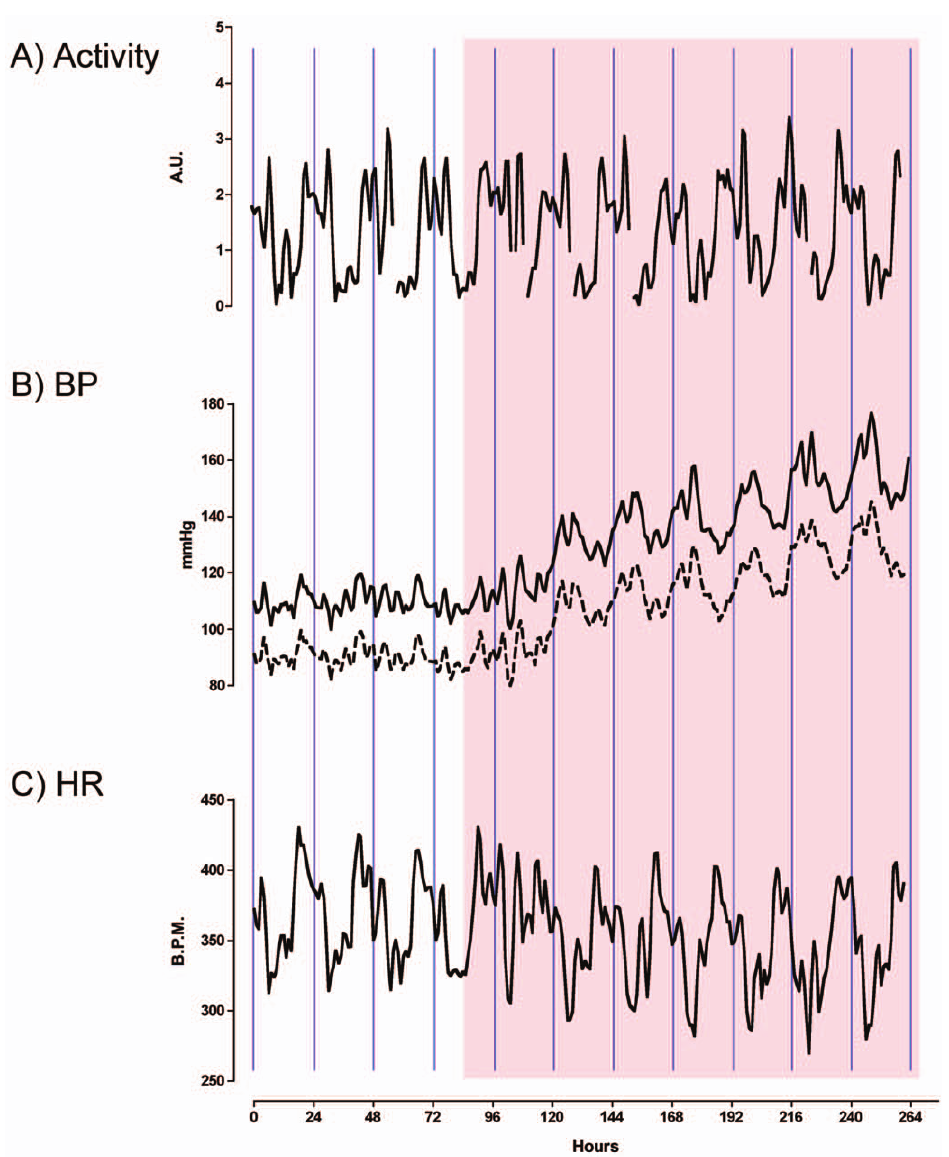
Figure 1. Telemetry data from Cyp1a1-Ren2 transgenic rats. Recordings were made in rats (n=5) over a baseline period and following 7 consecutive days of indole-3-carbinol administration (I3C; Shaded area). A) locomotor activity; B) Blood pressure (BP), with systolic as a solid line and diastolic as a dashed line and C) HR. Data are hourly means, smoothed with a 5-point rolling average and shown without error bars for clarity. The vertical lines represent the midnight time point. I3C was administered at 10am.